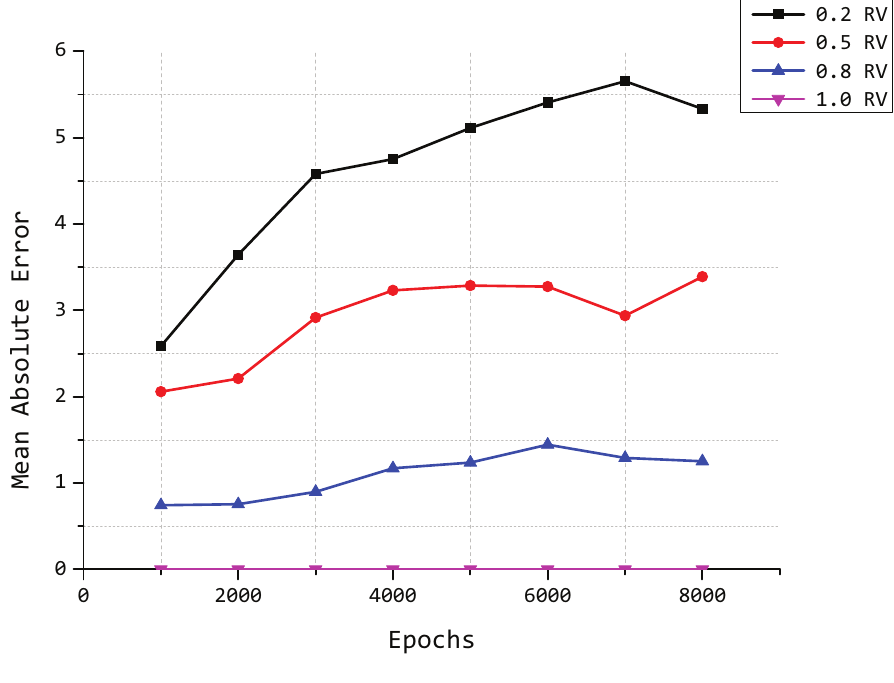
Figure 10. Mean square error for different values of δ . RV, retained